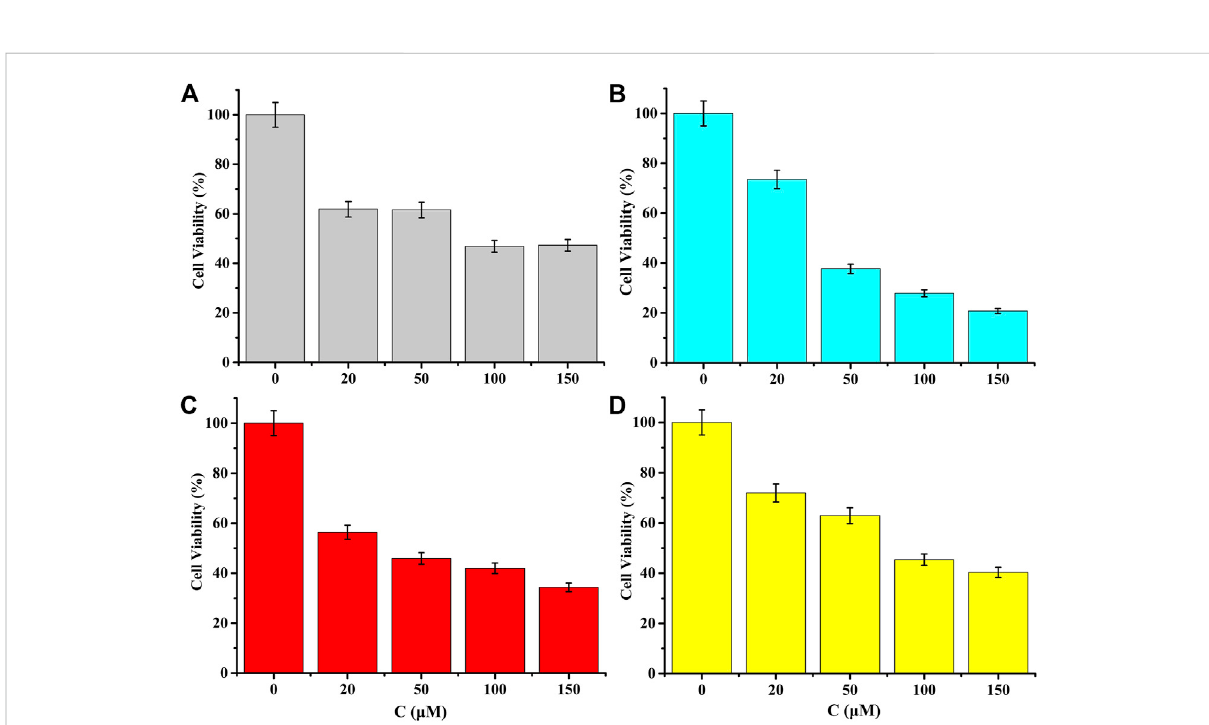
FIGURE 4 MTT assays on tumor cell lines showing cell viability (for (A) Hela of complex 5, for (B) HepG2 of complex 5, for (C) MDA-MB-231 of complex 5 and for (D) MDA-MB-231 of 5-FU). Data represent at least three independent experiments.